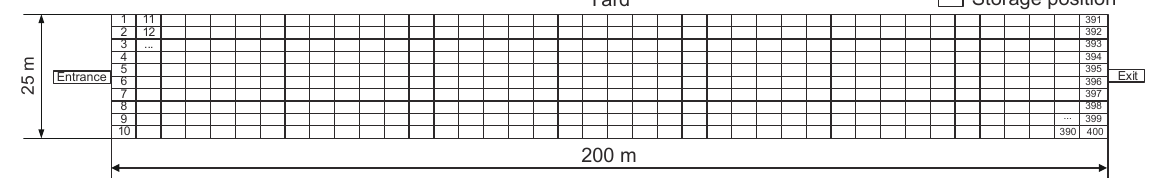
Fig. 12 Layout of the yard of the case